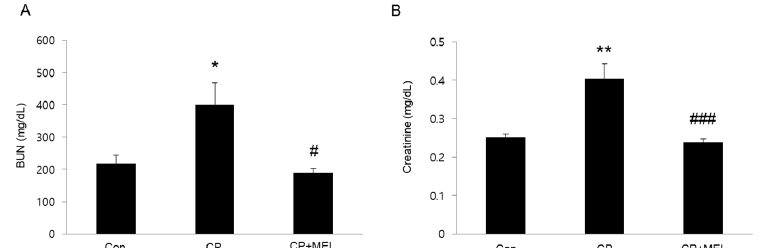
Figure 1. Effects of melatonin (MEL) on renal function in mice treated with cisplatin (CP). ( A ) Serum levels of blood urea nitrogen (BUN). ( B ) Serum creatinine levels. * P < 0.05 and ** P < 0.01 vs. Con. # P < 0.05 and ### P < 0.001 vs. CP.